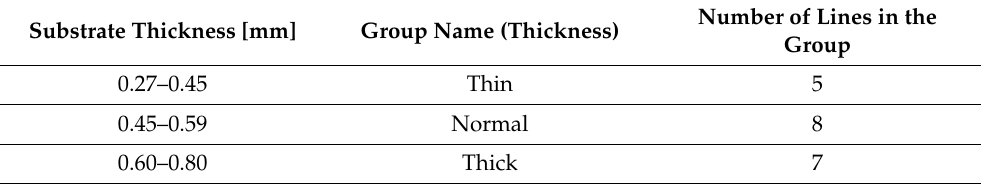
Table 3. TSL’s population, divided into groups based on their substrate thickness.